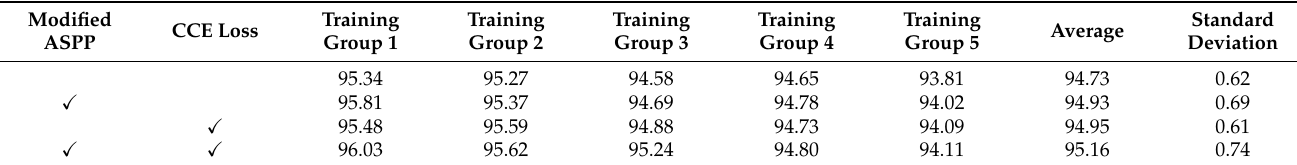
Table 5. Detailed configuration of DA-EMA units.